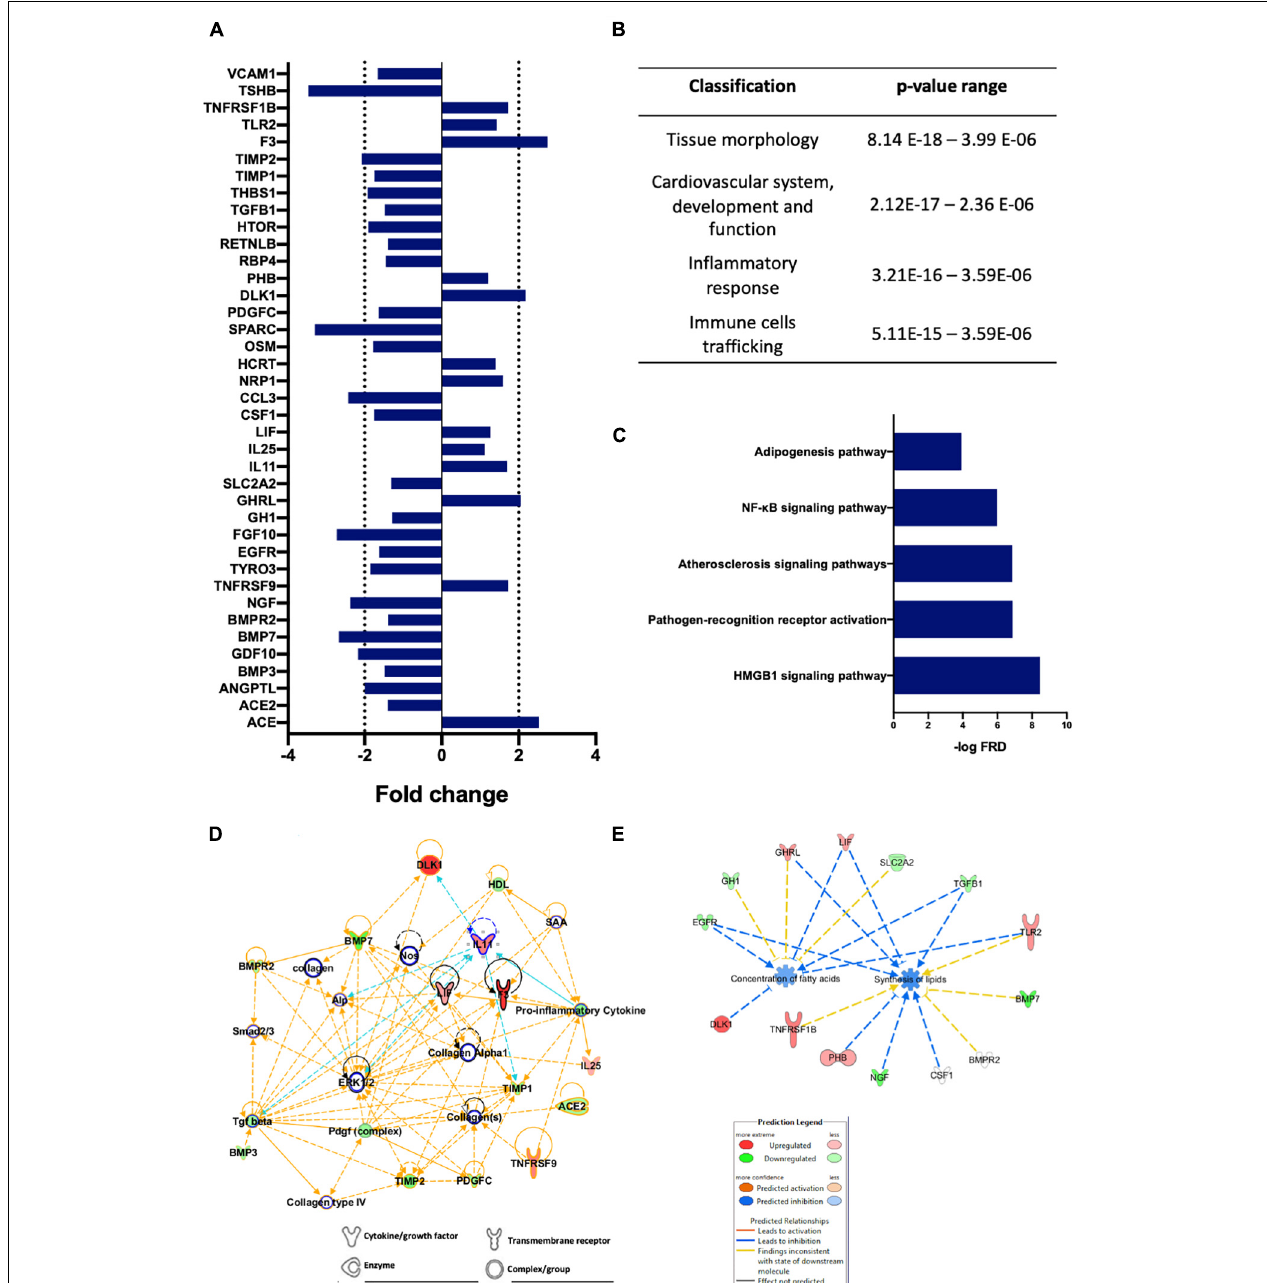
FIGURE 3 | Differential expression of plasma proteins and downstream analysis showing the main regulated pathways after BOSB consumption. (A) Fold-changes of the modulated plasmatic proteins after the BOSB consumption; (B) Top morphological functions; (C) Top regulated canonical pathways; (D) IPA protein network associating cytokine/growth factors, enzymes, transmembrane receptors, and complexes; (E) Main regulated pathways linked to the synthesis of lipids.